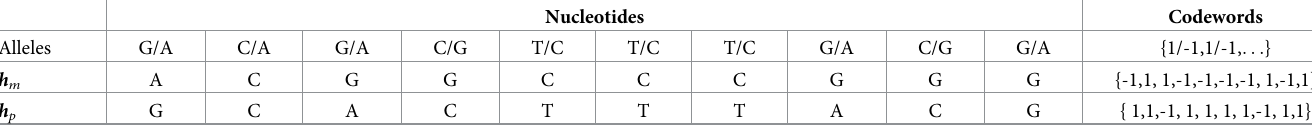
Table 1. Haplotypes of β 2 AR genes and their corresponding codewords.